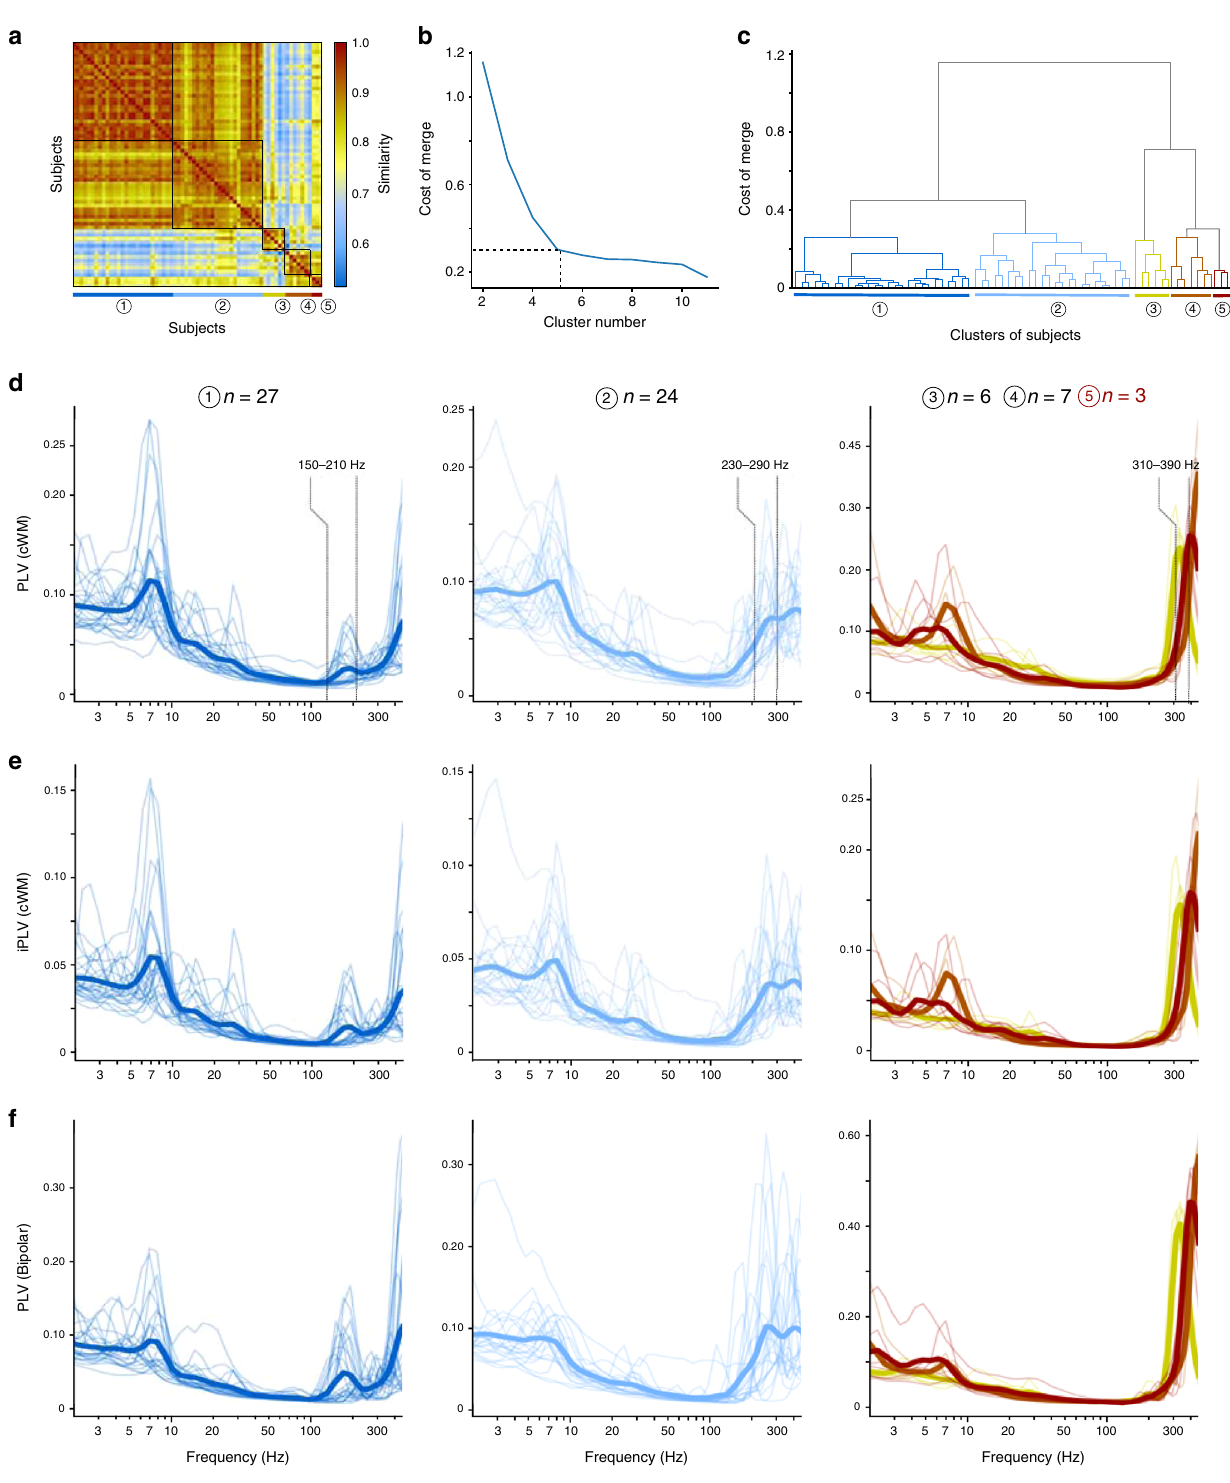
Fig. 3 Clustering subjects by similarity in synchrony patterns across frequencies. a Similarity matrix of HFO synchronization pro fi les (cWM) across the subject cohort. The matrix was sorted by hierarchical clustering and partitioned to fi ve clusters (black squares corresponding to dendrogram in c ). b The cost of merging subject clusters. c The dendrogram derived from the similarity matrix in a showing the individual subjects and their division into the fi ve subject clusters. d Individual (thin lines) and mean (thick lines) cWM- referenced PLV, e iPLV, and f bipolar-referenced PLV of the subject